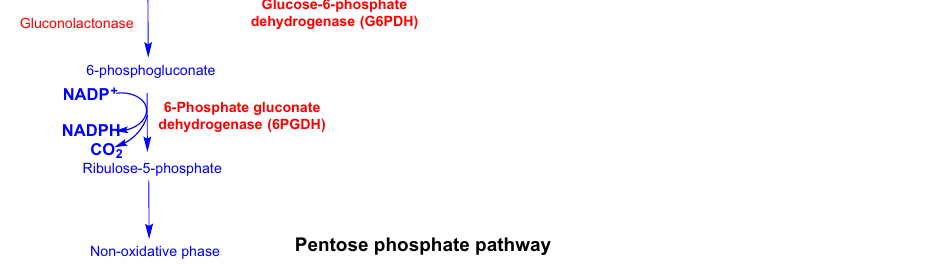
Figure 1. General scheme of the reactions of the pentose phosphate pathway (PPP) with the enzymes of the oxidative phase highlighted in